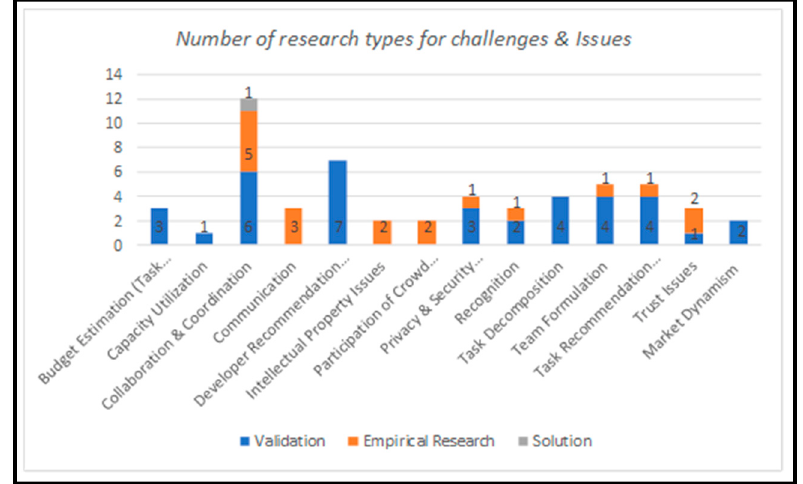
Figure 2. Research study types for each addressed issue and challenges.